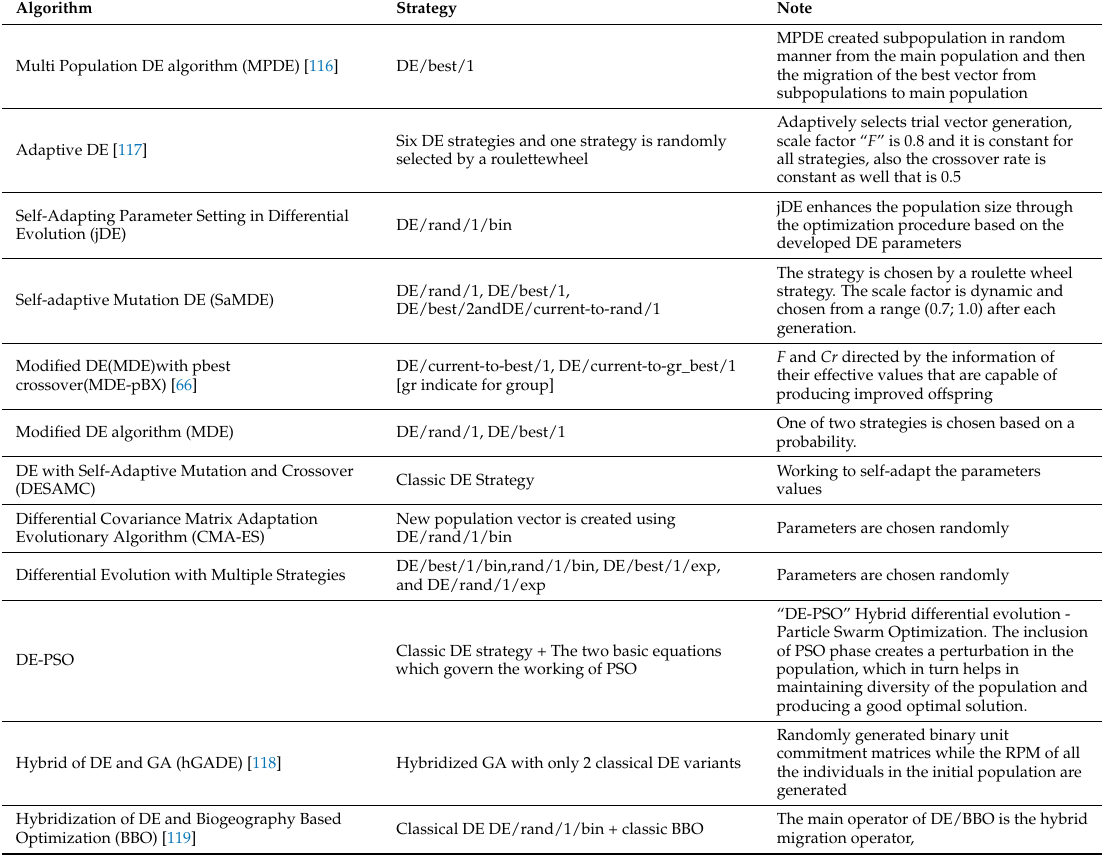
Table 2. Summary of different DE algorithms with variety of